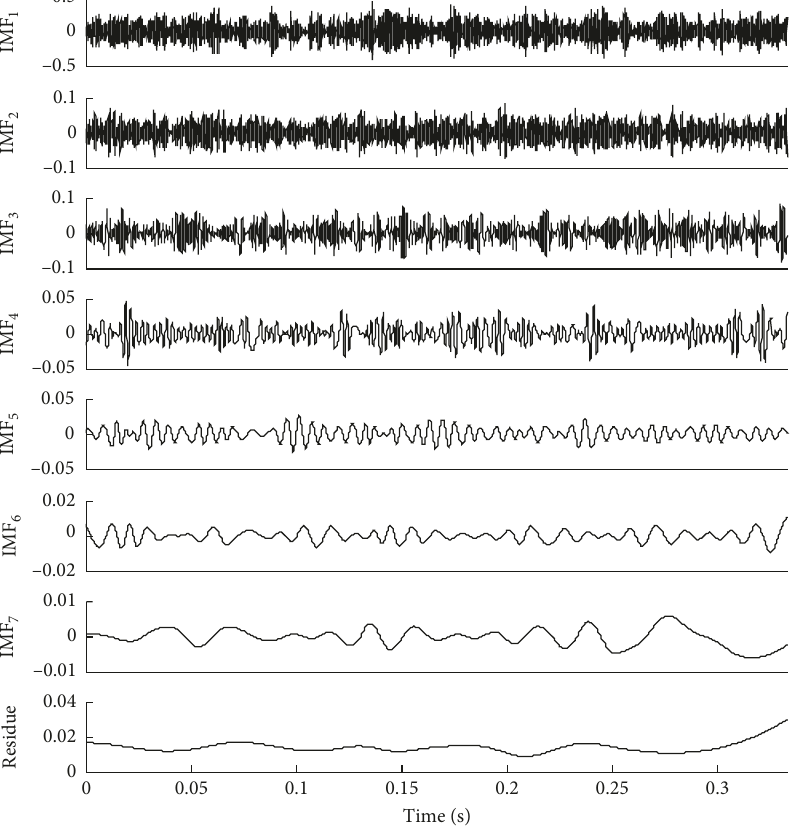
Figure 14: The decomposing results generated by EMD of a vibration signal from class